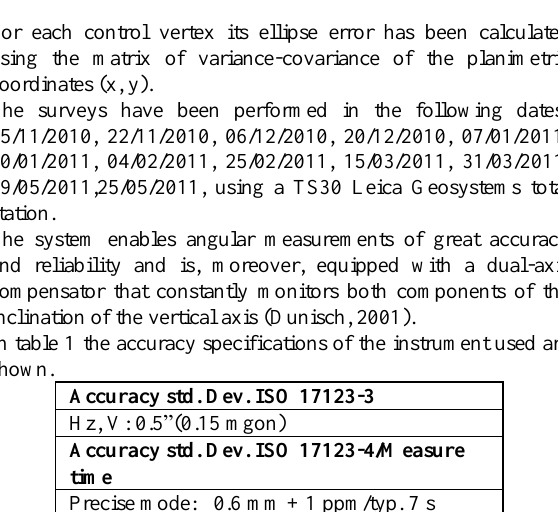
Table 1. Accuracy TS30